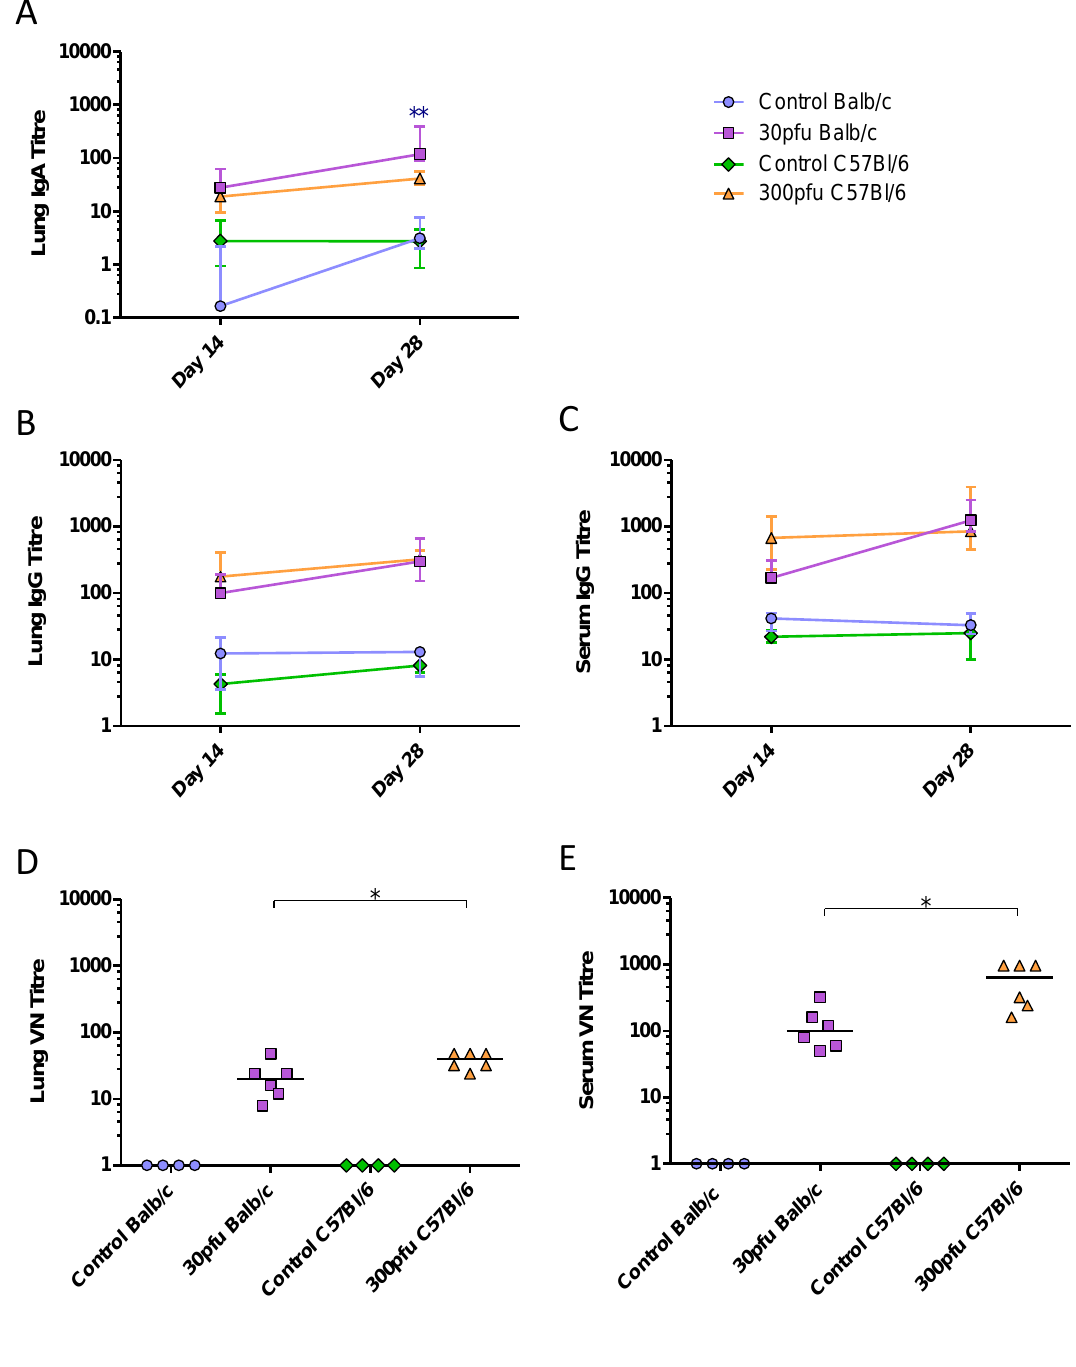
Figure 7. PVM-specific antibody response in the serum and lungs. Five to six week-old Balb/c and C57Bl/6 mice were inoculated with medium, 30 pfu (Balb/c) or 300 pfu (C57Bl/6) of PVM 15 and sacrificed on days 14, 28, and 42 p.i.. Time course of ( A ) lung IgA, ( B ) lung IgG, and ( C ) serum IgG, represented as the group median with vertical lines indicating the interquartile range. VN titres on day 28 in lung ( D ) and serum ( E ). Each data point represents a single animal and the line represents the group median. *, p <0.05; **, p